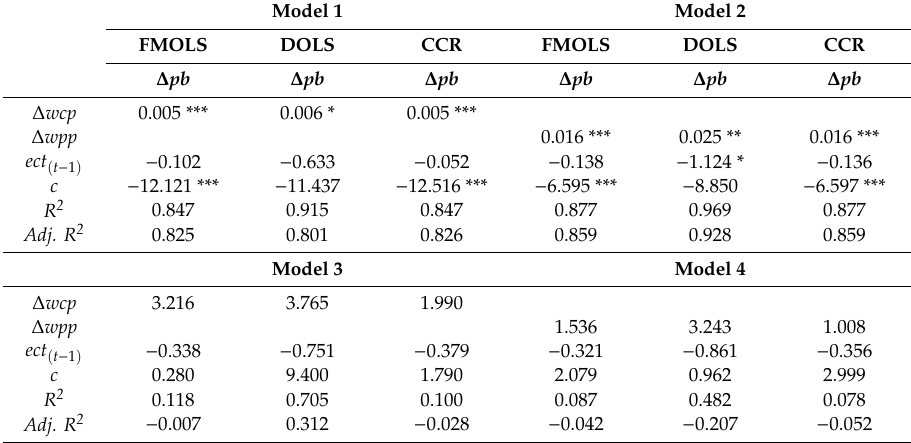
Table 8. The dependency of oil price on the World GDP, industry production, demand and supply for